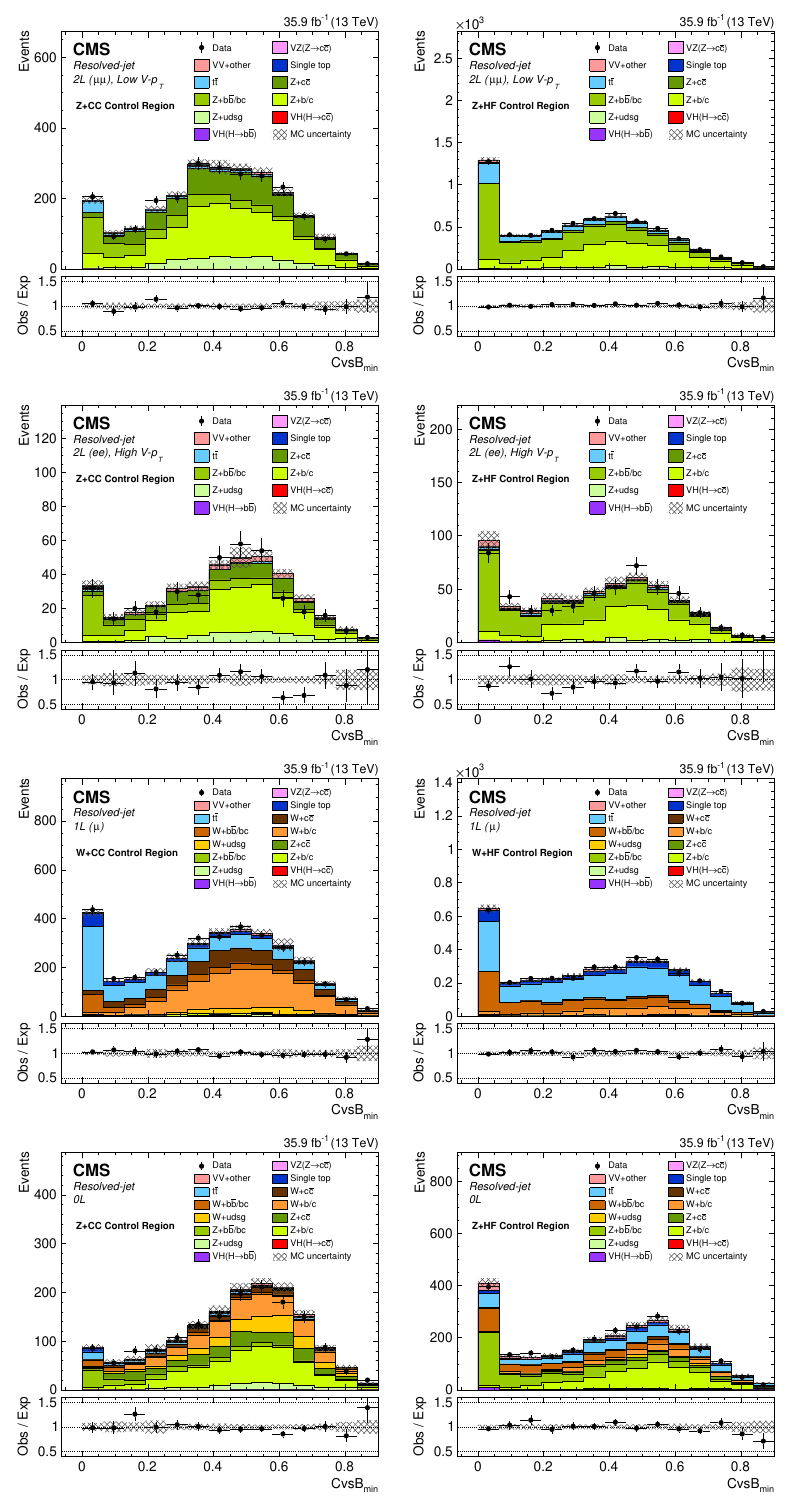
Figure 2 . Post-(cid:12)t CvsB for the 2L (Z( mm )) low- p